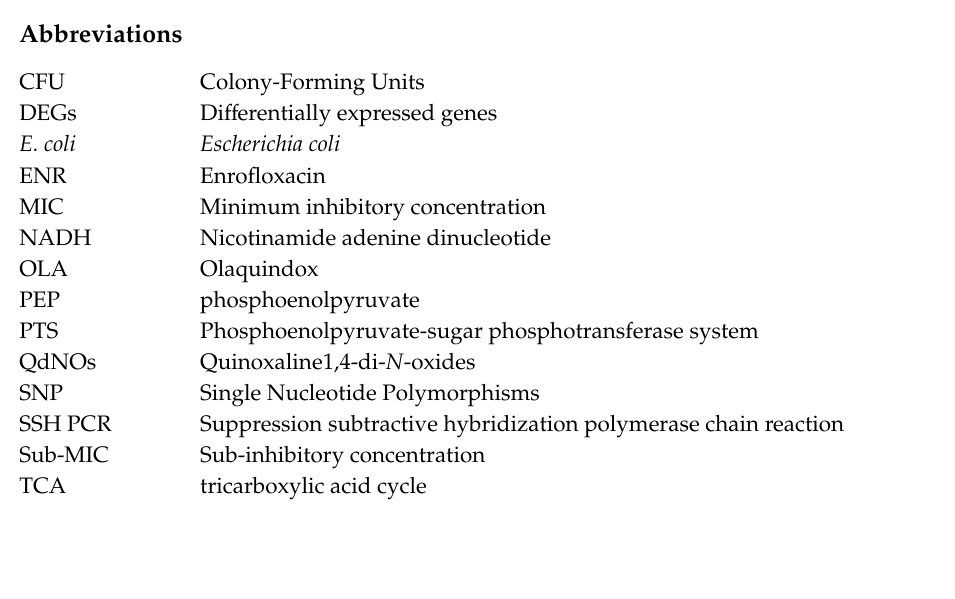
Figure S1: Resistance rates of E. coli ATCC25922 exposed to ENR at sub-MIC concentrations of 1 / 2 × MIC (A), 1 / 4 × MIC (B), 1 / 10 × MIC (C) and 1 / 100 × MIC (D), Figure S2. Scanning electron micrograph of E. coli ATCC25922 induced by none (A), 1 / 2 × MIC ENR (B) and 1 / 2 × MIC OLA(C)., Figure S3. Correlation tests for 9 samples (triplicates in each group) of the untreated (group B), 1 / 2 × MIC (group C) and 1 / 10 × MIC OLA (group D) -treated E. coli ATCC25922. The abscissa and ordinate in the figure are sample numbers. The closer the block value is to 1, the higher the similarity is., Figure S4. Venn diagrams of DEGs. The numbers in each circle represents the total number of DEGs in the comparison combination, and the overlapping part of the circles represents the DEGs shared between the comparison groups. B, untreated group; C, 1 / 2 × MIC OLA-treated group; D, 1 / 10 × MIC OLA-treated group., Figure S5. The genome of 1 / 2 × MIC OLA induced E. coli ATCC25922 resistant to 8 × MIC OLA. The circles from outermost to innermost indicated the scale, GC content (red: > average value, blue: < average value), GC skew (purple: > 0, orange: < 0), noncoding RNA (tRNA in black, rRNA in red), minus-stranded CDS maps, plus-stranded CDS maps, minus-stranded base-modified map (full red circle), plus-stranded base-modified map (full blue circle), gene map of the restriction modification system, respectively., Figure S6. Protein length distribution of the genome of OLA resistant E. coli ATCC25922., Figure S7. COG function classification of OLA resistant E. coli ATCC25922. The abscissa is the group of the COG, and the ordinate is the number of genes annotated to the group., Figure S8. GO function annotation of OLA resistant E. coli ATCC25922. The ordinate is the three major classes of the GO term including biological processes, cellular components, and molecular functions, the abscissa is the number of genes annotated to the term (including the term of the term)., Figure S9. KEGG functions annotation of OLA resistant E. coli ATCC25922. The ordinate is the name of the KEGG metabolic branches according to the involved KEGG metabolic pathway including Cellular Processes, Environmental statistics., Table S4. Number of di ff erentially expressed genes between groups B and C., Table S5. Di ff erentially expressed genes between groups B and